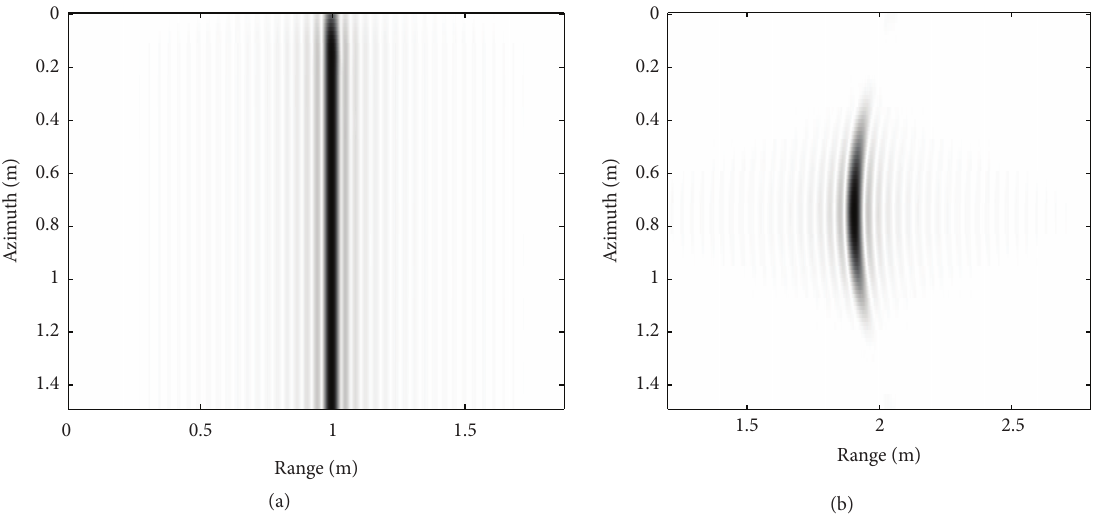
Figure 9: Range-compressed images of a simulated stepped frequency SAR system. (a) a scene containing scatterers modeling a simple wall model located at 0.99 m in range, used to populate the wall dictionary. (b) a scene containing one-single point target located at range 1.9m and azimuth 0.75 m, used to populate the point-target dictionary.